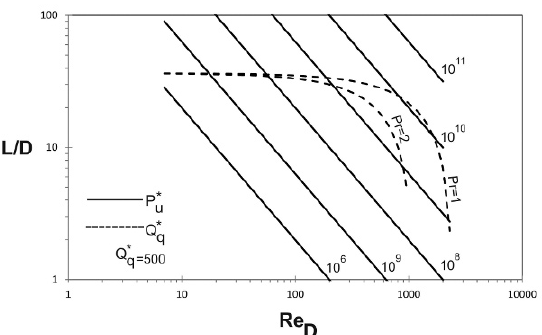
Figure 7. Influence of the Prandtl number on the variation of L/D groupwiththeReynoldsnumber(laminarregimeandcon- stant heat-flux